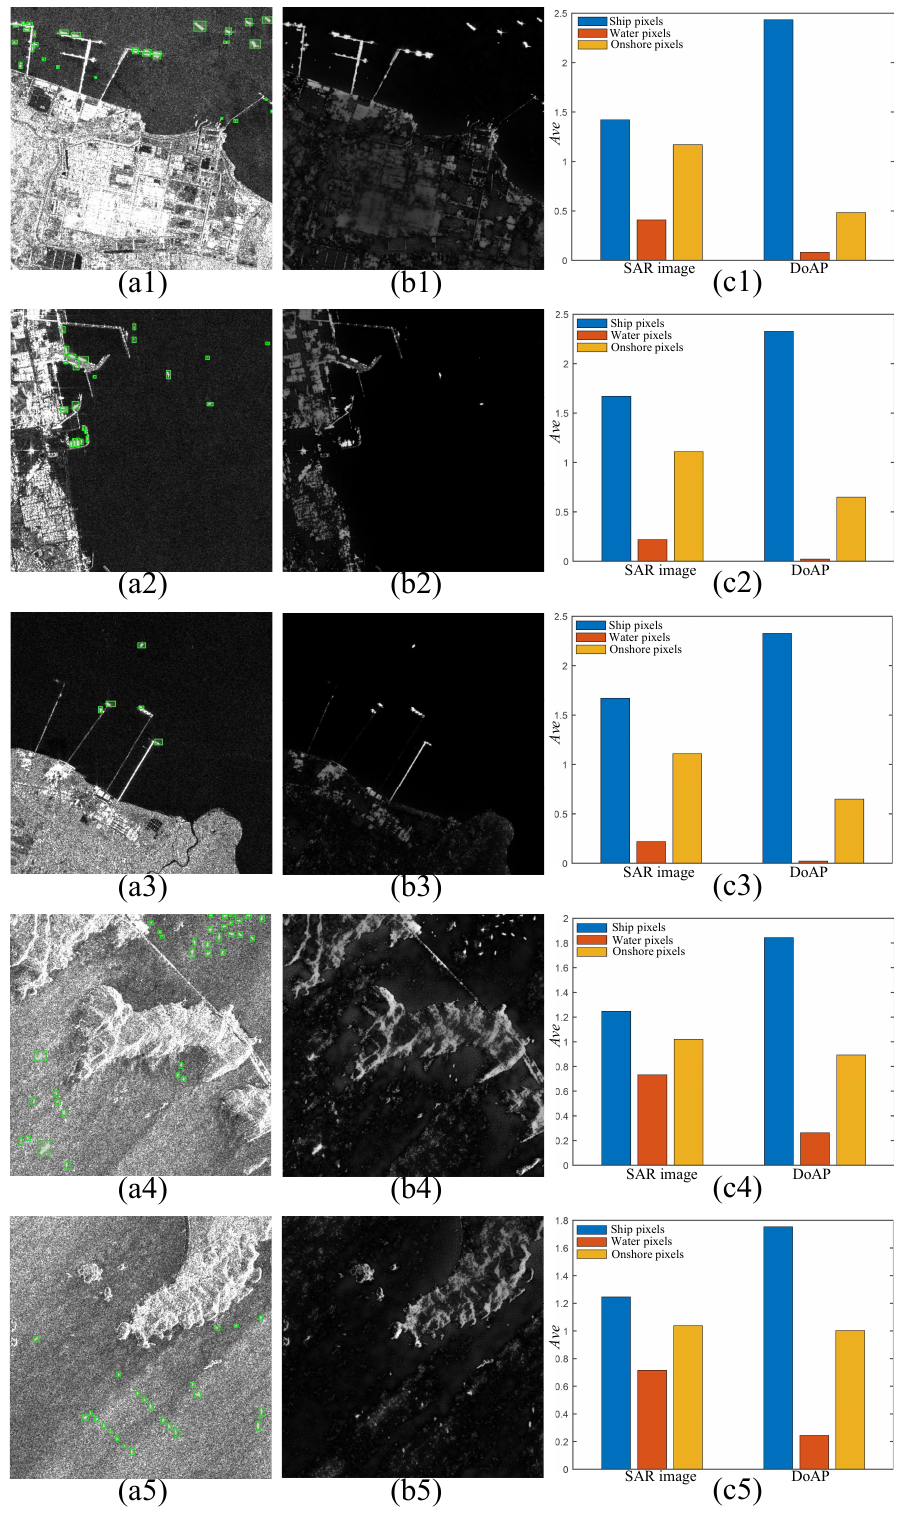
Figure 9. Results of final saliency enhancement. ( a1 )–( a5 ) Ground truth maps. ( b1 )–( b5 ) Final saliency enhancement results obtained by the DoAP. ( c1 )–( c5 ) The contrast results of ship pixels, water pixels, and onshore